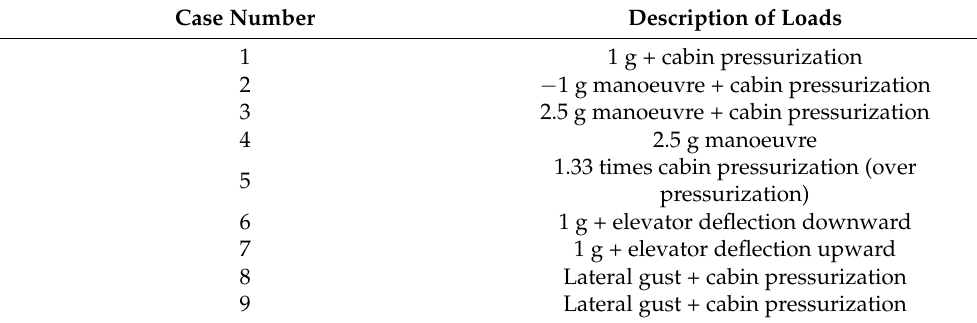
Table 7. Fuselage fan integration structural load cases based on CS-25 (cf.